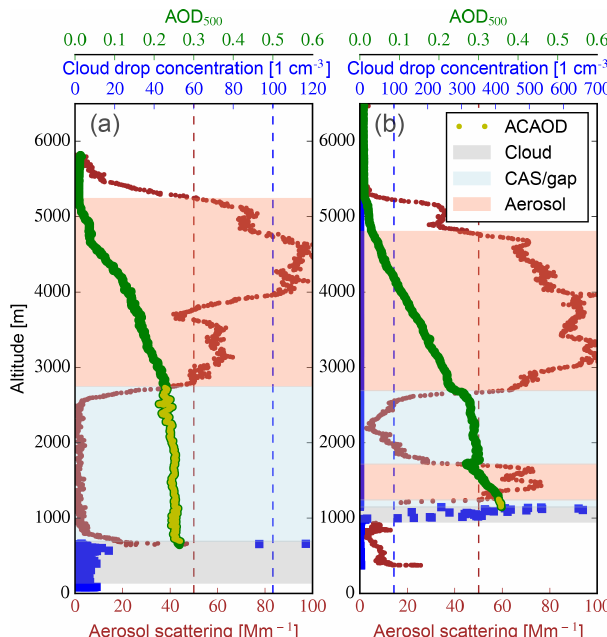
Figure 3. Examples of profiles of cloud drop concentration from PDI, aerosol scattering (at 550nm) from HiGEAR’s nephelometer, and AOD measurements used to evaluate the ACAOD portion of the total AOD column taken from flight on 12 September 2016. (a) Case from 18.6 ◦ S, 8.6 ◦ E where there is a gap (light blue shad- ing) between cloud top (grey shading) and an aerosol layer (light red shading). The yellow markers within the green AOD profile denote the vertical portion of the flight representing the ACAOD. (b) Case from 10.2 ◦ S, 0.2 ◦ E with a near-zero separation between cloud top and aerosol layer but with an embedded gap within the aerosol layer. For this case, only the AOD directly above clouds is considered the